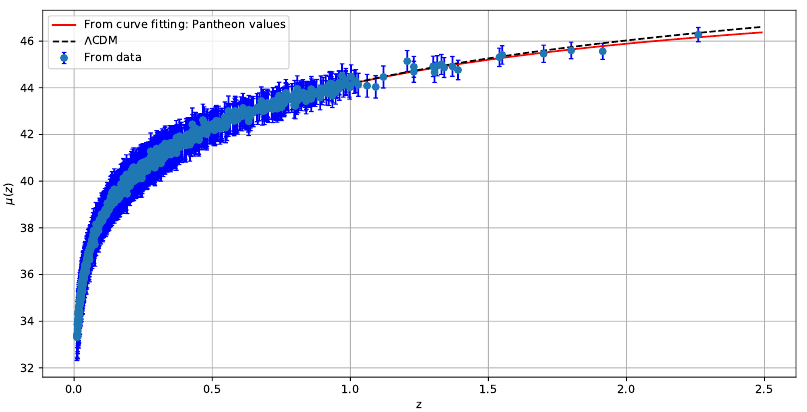
Figure 2. The evolution of µ ( z ) with respect to redshift z is shown here. The red line represents our model (i.e., the profile of H ( z ) as presented in (26)) and dashed-line indicates the Λ CMD model with Ω = 0.3 and Ω Λ = 0.7. The dots are shown in the 1048 Pantheon dataset with the error m 0 0